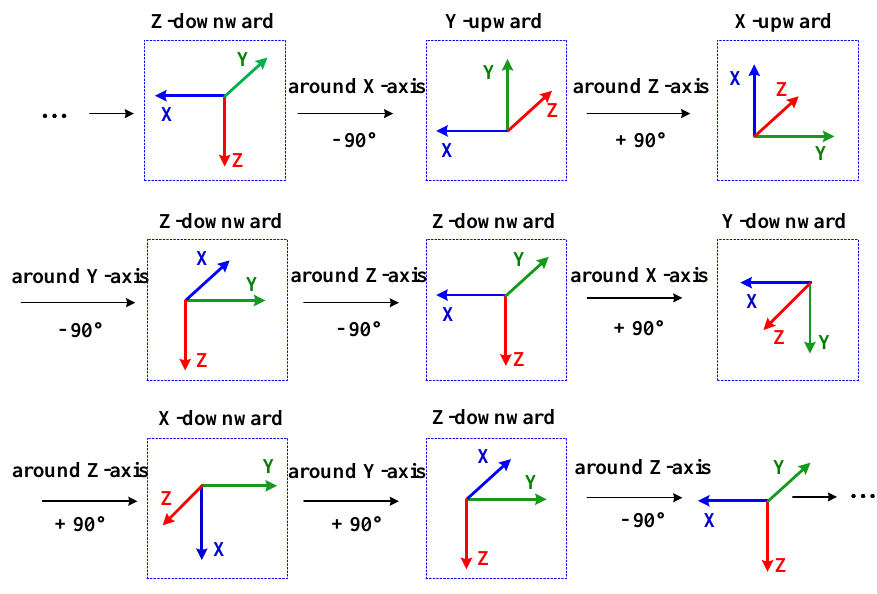
Figure 2. IMU actions in an 8-step calibration